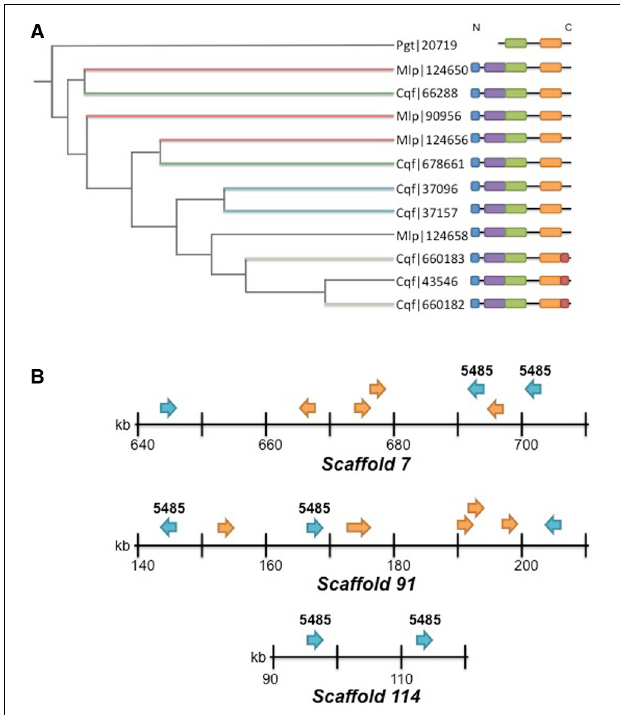
FIGURE 7 | Domain structure, phylogenetic relationships, and colocalization of copper oxidases. (A) Phylogenetic relationship estimated with TreeFix (Wu et al., 2013) for the 12 members of Family 5485. Tree reconstructed with Tree of Life viewer (Letunic and Bork, 2011). See methods for additional details for gene tree estimation. Branch lengths are not informative for this tree. Domain architectures are indicated for each protein: N-terminal signal peptides per SignalP 4.0 (blue; Petersen et al., 2011); (MCu1—IPR01117) Multicopper oxidase Type 1 (green); (MCu2—IPR011706) Multicopper oxidase Type 2 (orange); (MCu3—IPR011707) Multicopper oxidase Type 3 (purple); and (CuBS—IPR002355) Multicopper oxidase, copper-binding site as determined by InterPro (red; Hunter et al., 2012). The colocalization of proteins on scaffolds is indicated by branches sharing the identical colors. Thin black branches do not colocalize. (B) Co-localization of proteins within MCO Family 5485 on scaffolds 7, 91, and 114. Family 5485 members are denoted with the ID above each gene model. Secretome members are blue arrows and non-secreted proteins are orange arrows. Gene orientation on the scaffold is indicated with arrows. Note: gene lengths are not to scale.